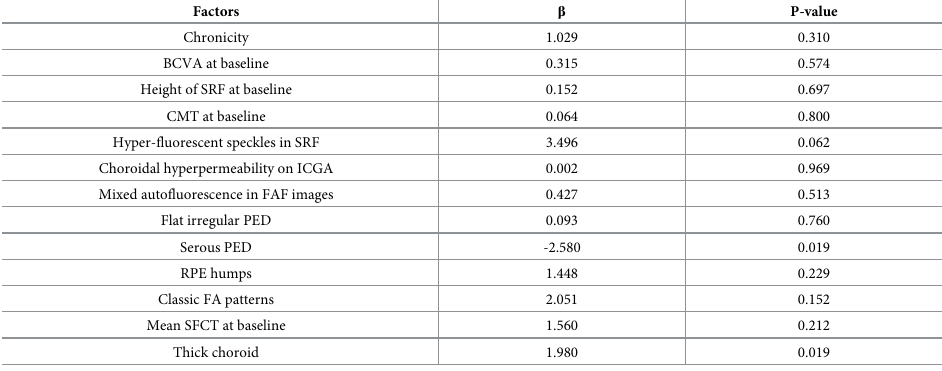
Table 3. Possible baseline predictive factors for recurrence after intravitreal bevacizumab injections for patients with central serous chorioretinopathy during a long-term follow-up period by binary logistic regression analysis.